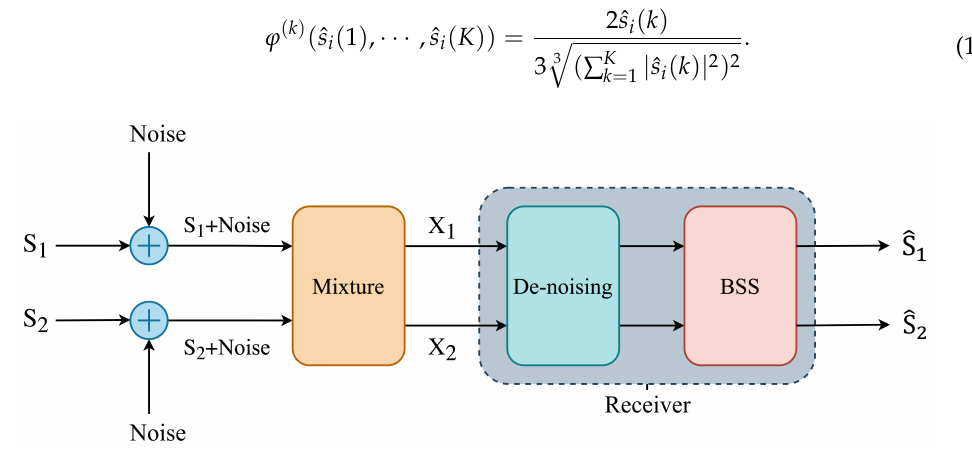
Figure 2. Second